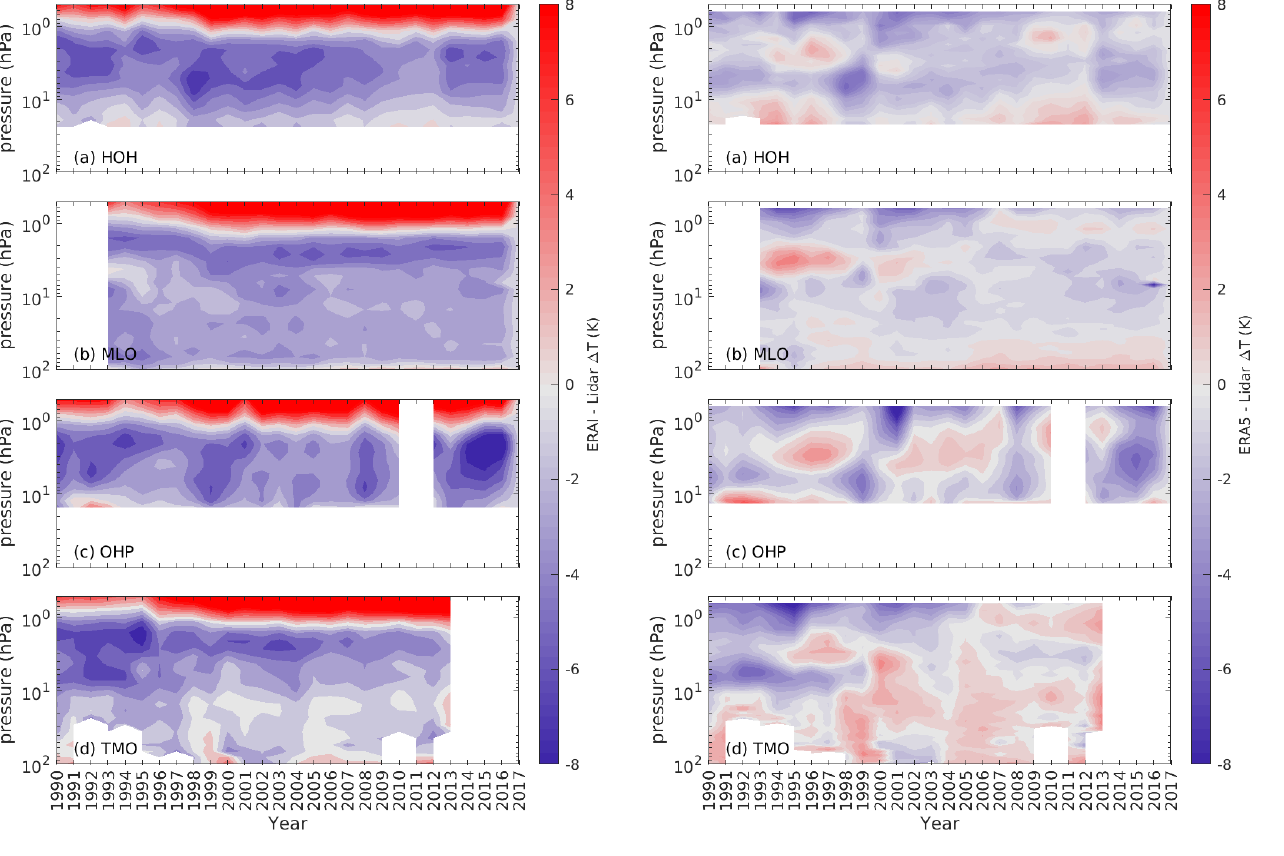
Figure 6. Annual Temperature bias between ERA-Interim and tem- perature lidars at (a) Hohenpeissenberg, (b) Mauna Loa, (c) Ob- servatoire de Haute-Provence and (d) Table Mountain Observatory plotted as a function of year and height between 1990 and 2017. Data gaps are given by white blocks.